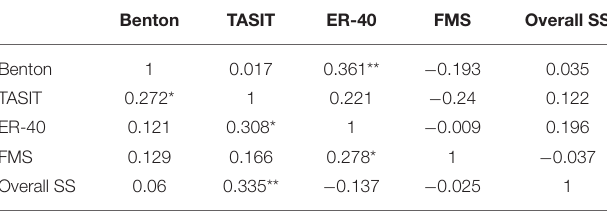
TABLE 4 | Correlations between predictors. TABLE 5 | Correlations between actor social abilities with actor